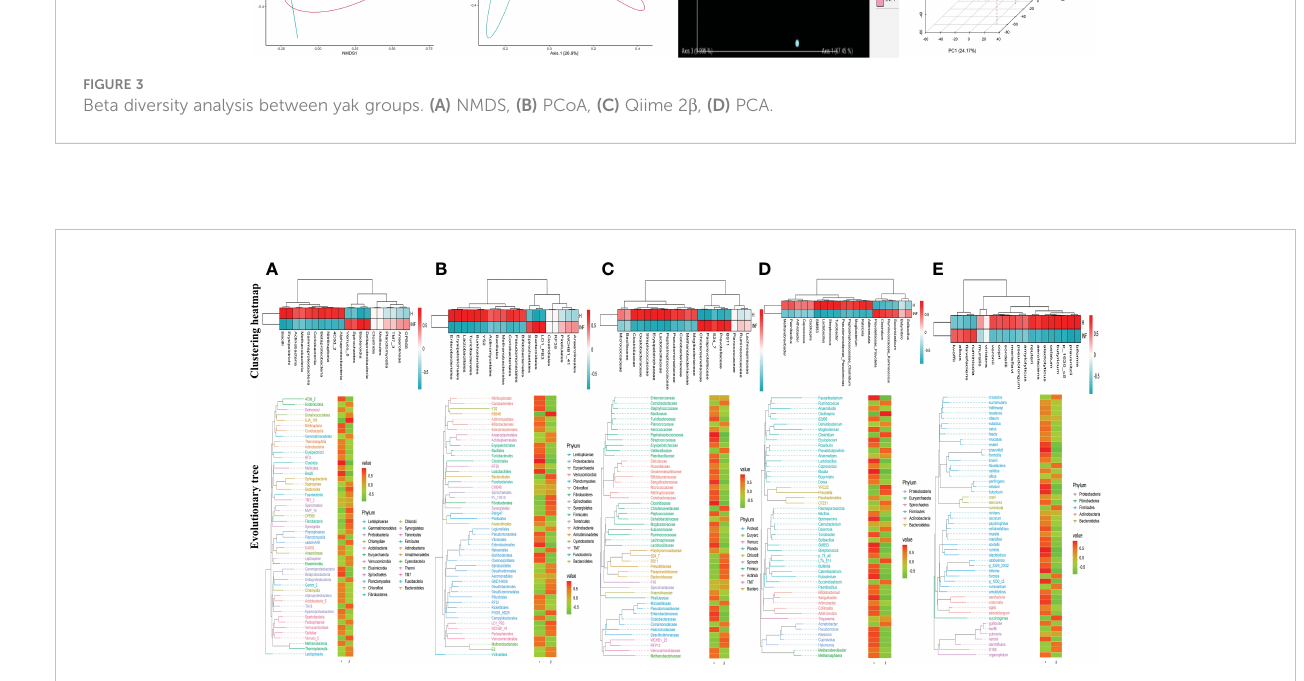
FIGURE 4 Clustering heatmap and evolutionary tree with heat map analysis of yak microbiota in different taxa. (A) Class, (B) Order, (C) Family, (D) Genus, (E)